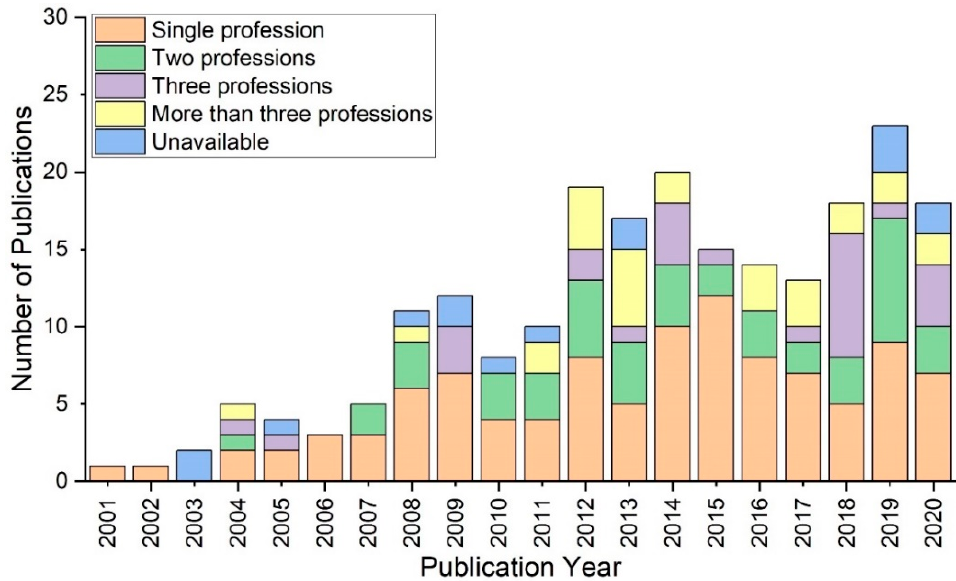
Figure 2. Number of studies involving professions between 2001 and 2020.